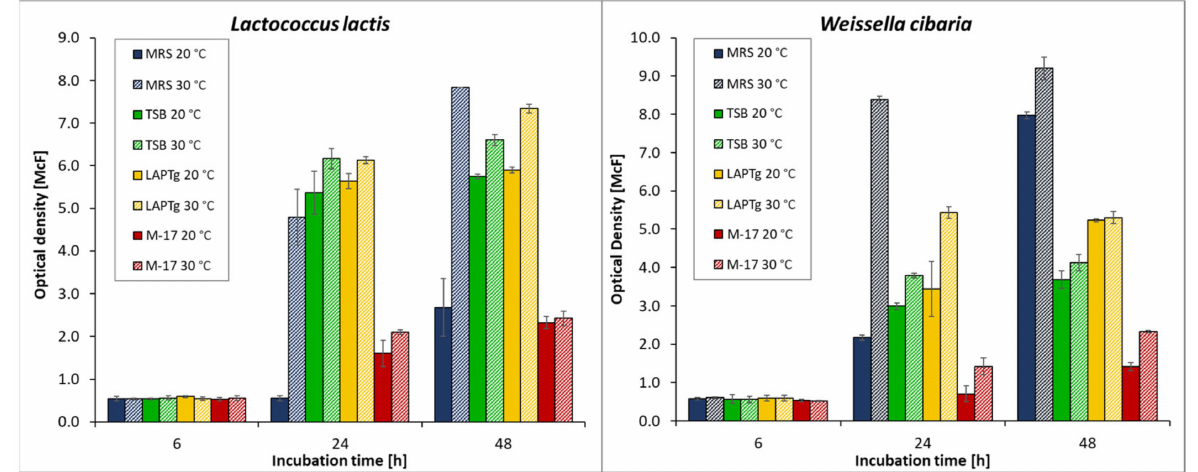
Figure 2. Graphs showing the growth of the tested LAB strains in various culture media and temperatures.